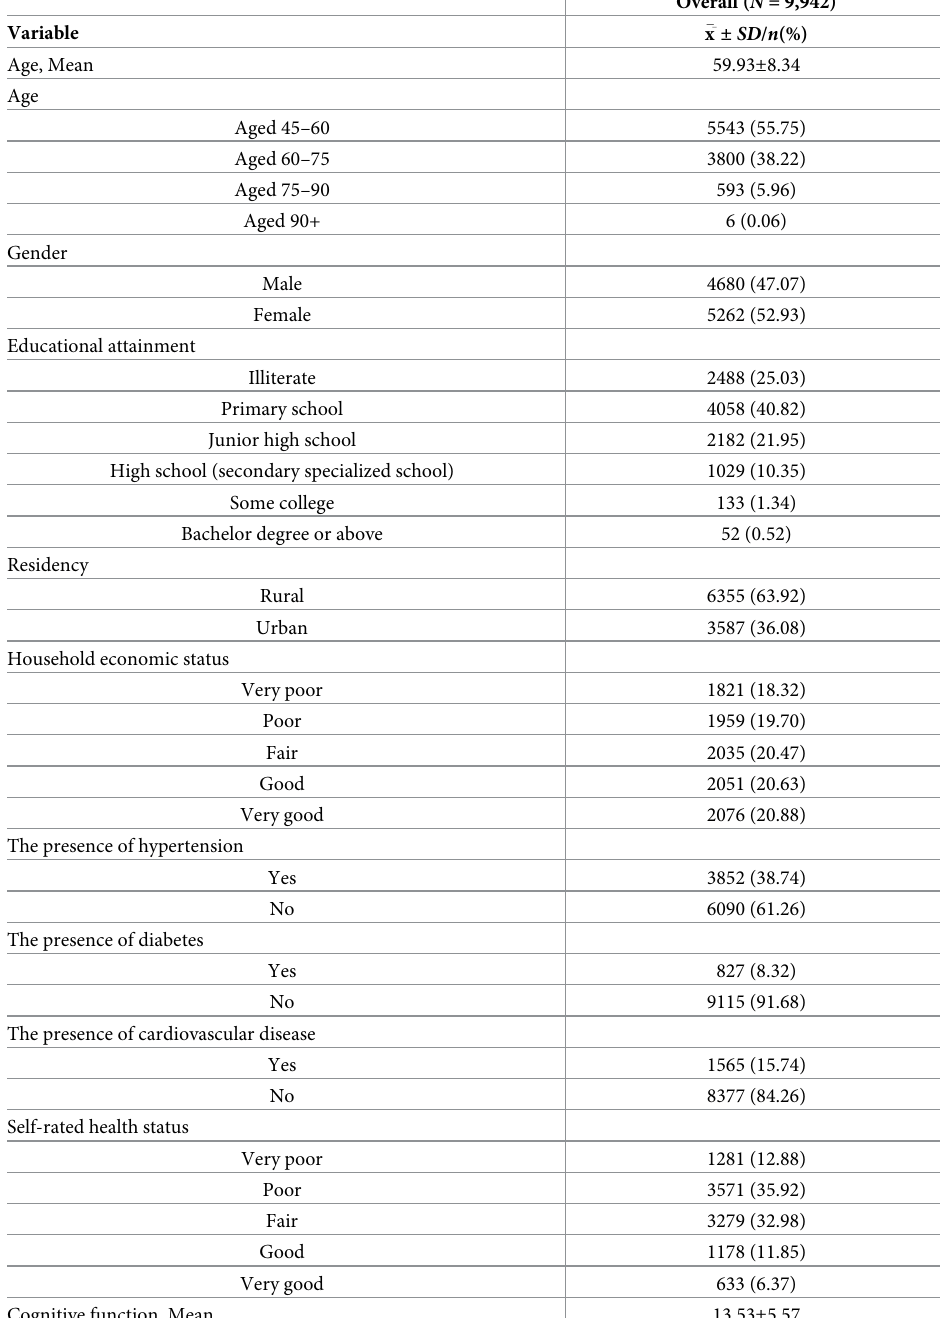
Table 1. Demographic characteristics of respondents